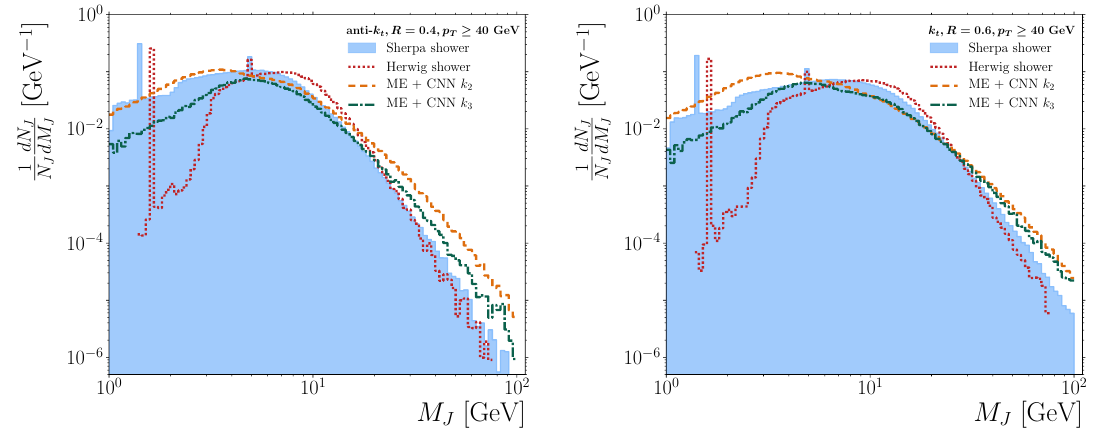
Figure 8 . Jet mass distributions using the anti- k t R=0.4 jet algorithm (left) and the k t R=0.6 algorithm